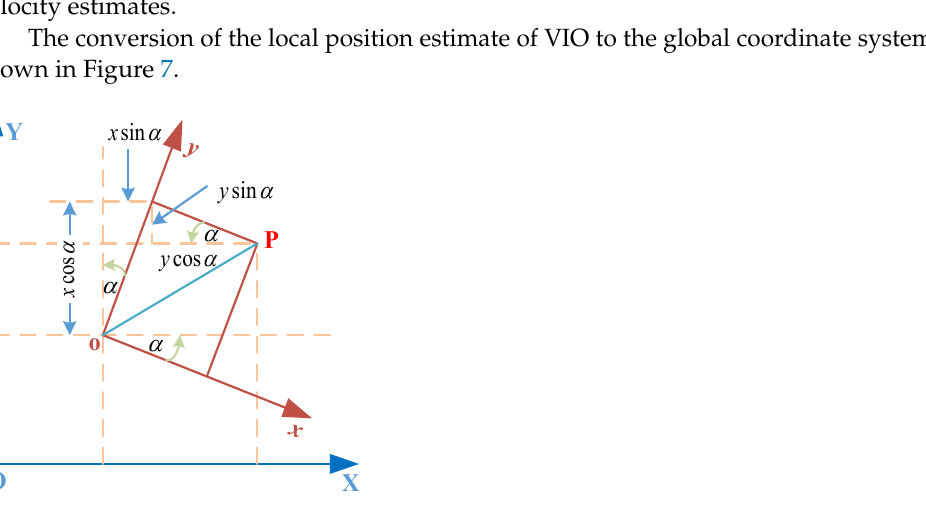
Figure 7. Coordinate transformation diagram, the point P is some point to be transformed, xoy is the local coordinate system, XOY is the global coordinate system and α is the angle of rotation. Assume that the output of a position is loc l = ( x l , y l ) in the local coordinate system and loc g = ( x g , y g ) in the global coordinate system, then the conversion formula for the local to global coordinates is